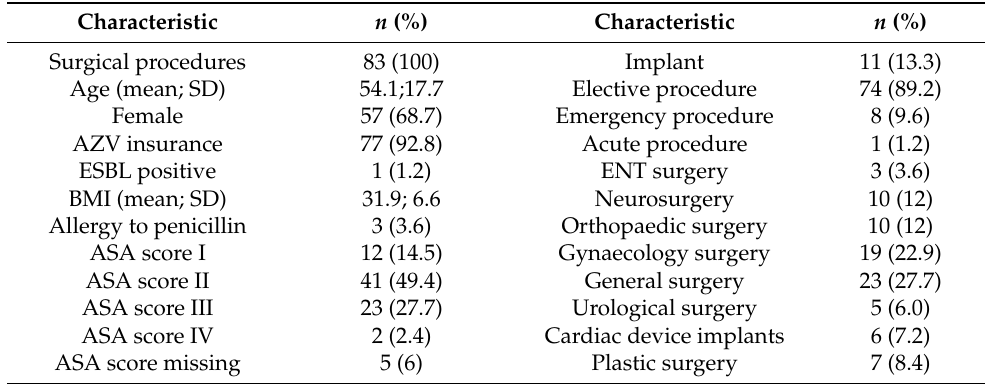
Table 1. Patients’ characteristics and surgical